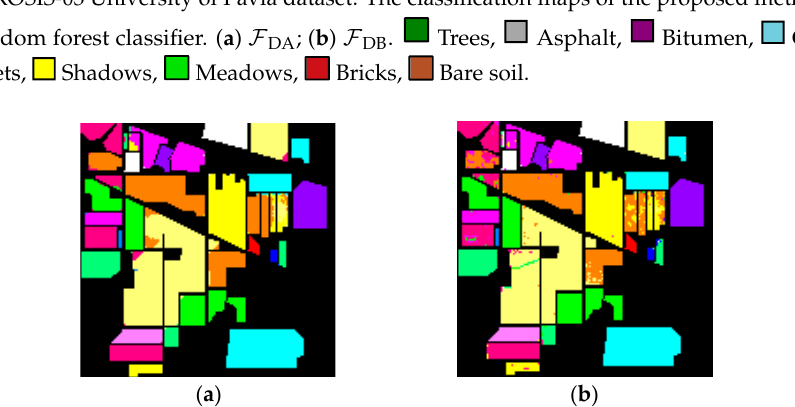
Figure 4. AVIRIS Indian Pines dataset. The classification maps of the proposed method obtain by the